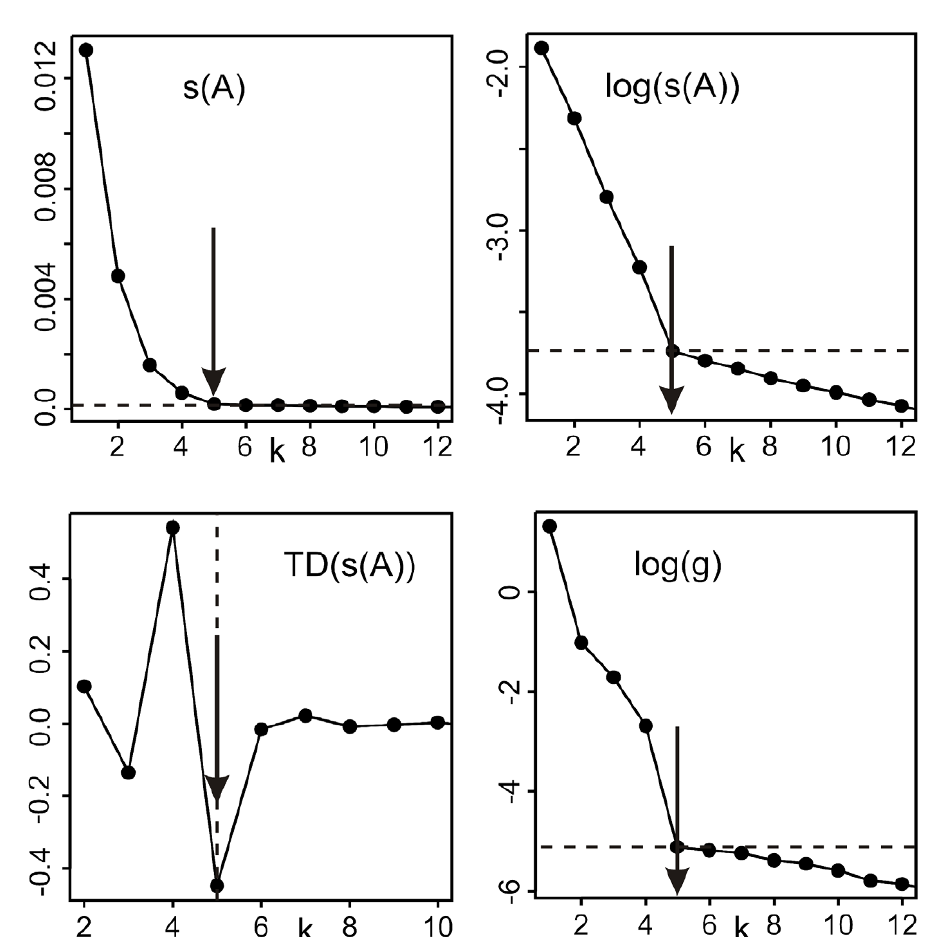
Figure 3. The dependence of the Cattel´s index plot of eigenvalues in form of four graphical methods as a function of the number of principal components k for the pH-absorbance matrix: Kankare’s residual standard deviation s(A), logarithm of Kankare’s residual standard deviation log(s(A)), the third derivation of residual standard deviation TD(s(A)), logarithm of eigenvalues log ( g ). The arrows indicate that all methods lead to 5 light-absorbing species in pH-equilibrium mixture (S-Plus).